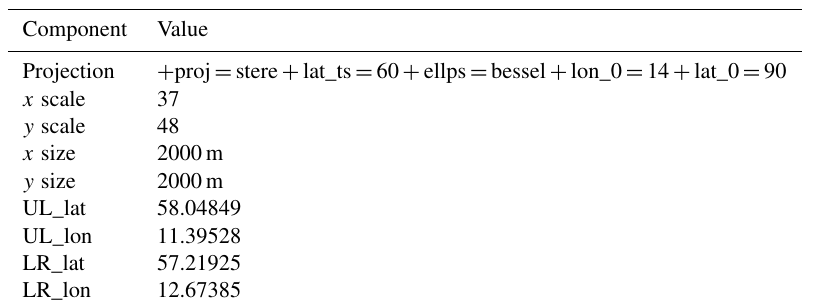
Table 2. Metadata of the radar data set with a 5min temporal resolution. Here the x and y scale represents the number of grid points in each direction and x and y size the spatial resolution of each grid cell. The upper left (UL) and lower right (LR) latitude (lat) and longitude (lon) coordinates are provided by the final four parameters. The projection is given as a “proj” string (https://proj.org/, last access: 29 November 2022).